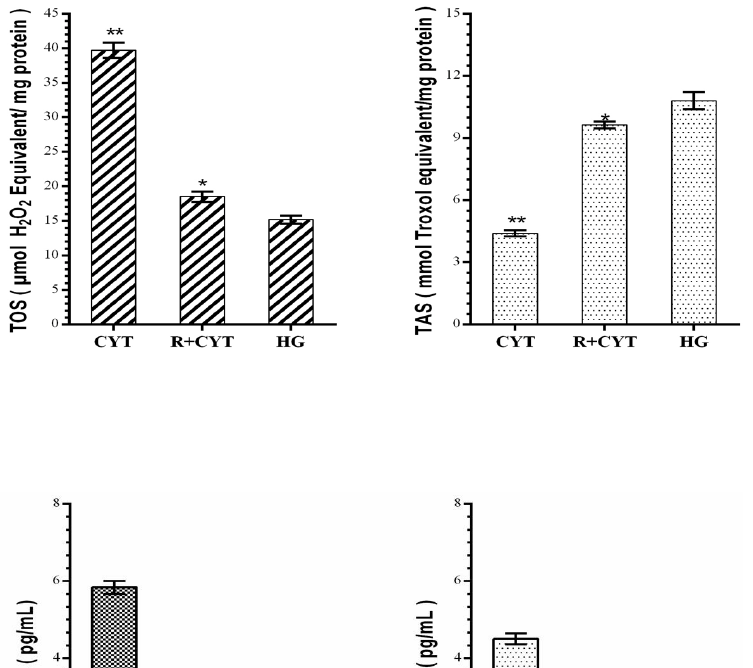
Figure 5. TNF-α and NF-κB content in the lung tissues of the rats in the control (HG), cytarabine (CYT) and rutin+cytarabine (R+CYT) groups. * p<0.0001 according to control (HG) group, ** p<0.0001 according to cytarabine